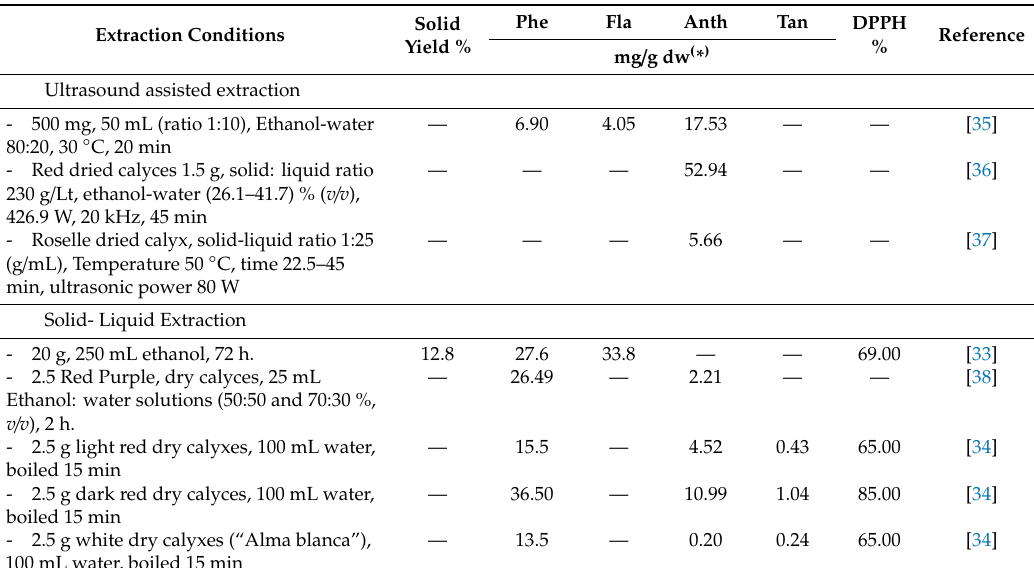
Table 2. Phytochemicals in calyx of Roselle ( H. sabdari ff a ) extracted with ultrasound assisted and solid-liquid